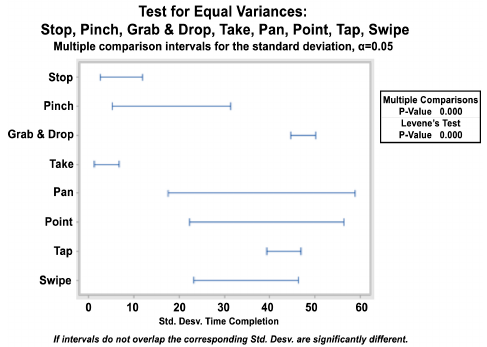
Figure 1. Test for Equal Variances in time.